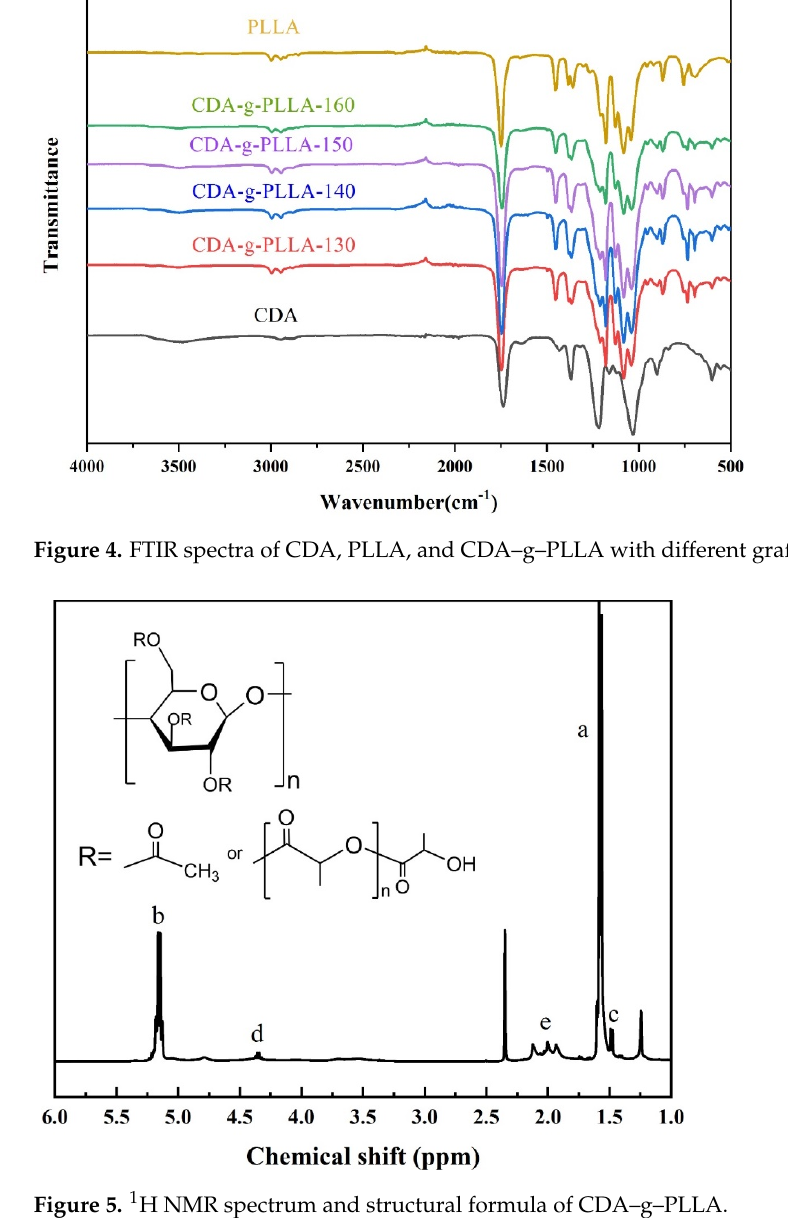
Figure 4. FTIR spectra of CDA, PLLA, and CDA − g − PLLA with different grafting temperatures.